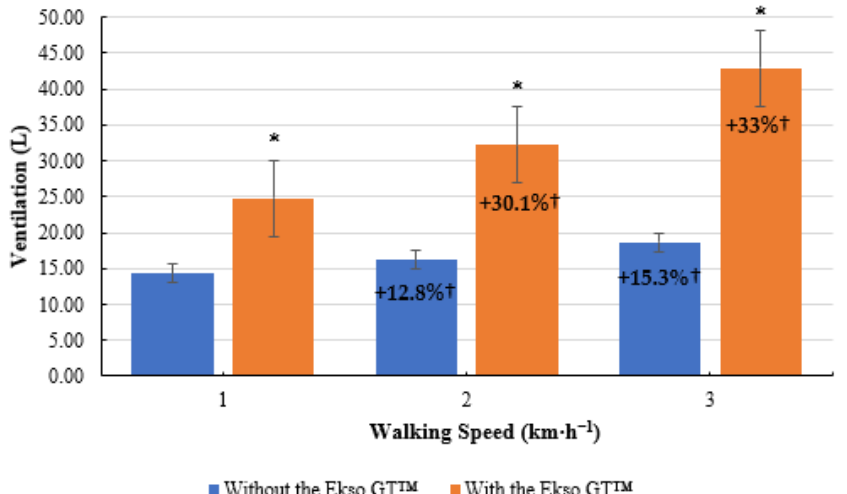
Figure 5. Mean ventilation ( V E ) results during treadmill walking both with and without Ekso GT™. * Significantly greater ( p ≤ 0.05) when walking with Ekso GT™ versus walking without Ekso GT™. † Mean percentage V E increase at each walking phase with and without Ekso GT™. 3.6. HR